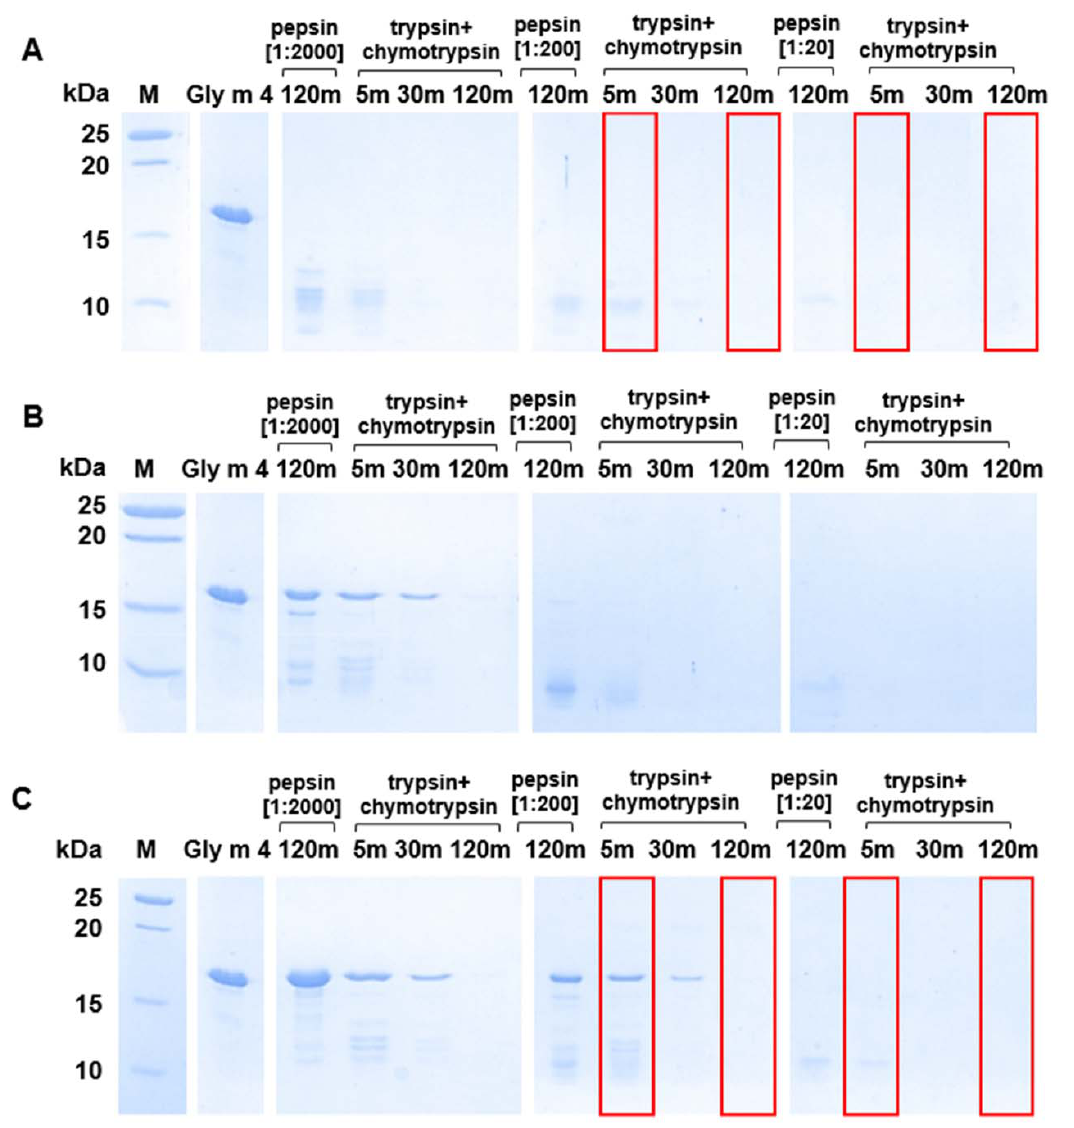
Figure 4. Effects of different gastric pH values ( A —pH 2.0; B —pH 3.5; C —pH 5.0) and pepsin loadings (1:2000, 1:200, and 1:20—enzyme-to-allergen mass ratios) on gastroduodenal digestion of Gly m 4, as detected by SDS-PAGE (15%T, 3%C in the separating gel). Gly m 4—the intact allergen; 5 m, 30 m, and 120 m—digestion time, min. M—molecular mass standards. Red frames show Gly m 4